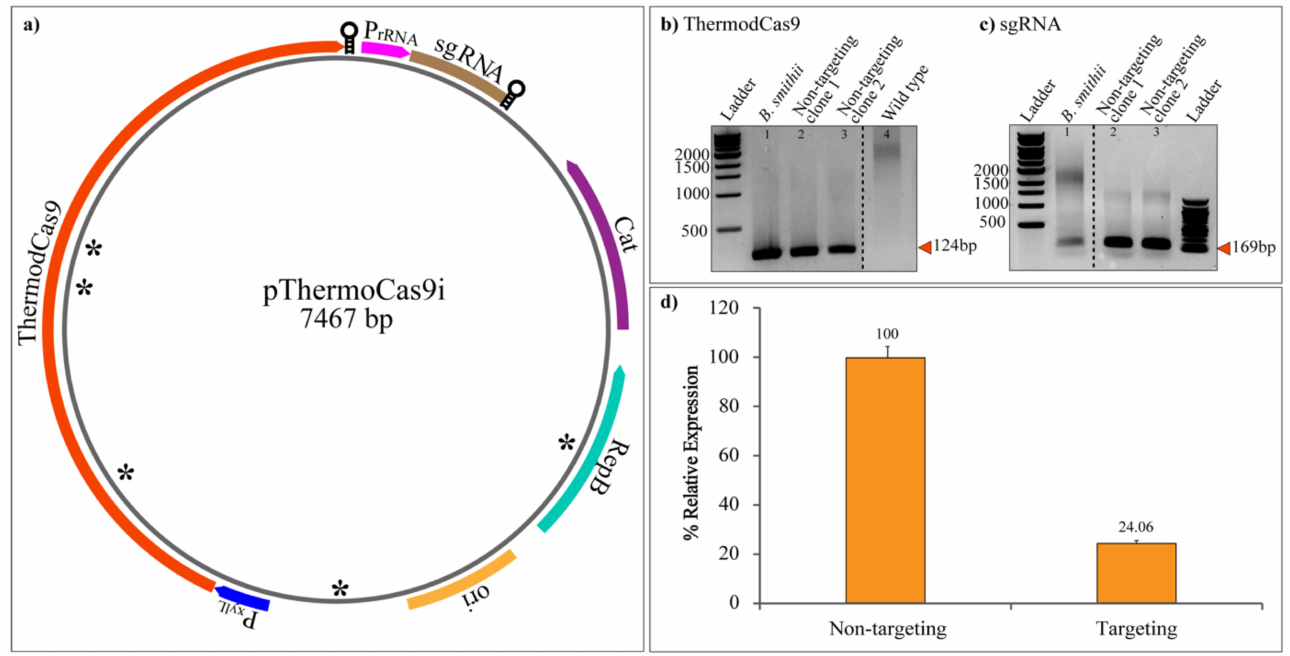
Figure 4. Transcriptional repression of malic enzyme gene by CRISPRi of P. thermosuccinogenes transformants. ( a ) Schematic representation of plasmid pThermoCas9i (Mougiakos et al. 2017b). The thermodcas9 gene under control of the B. smithii xylL promoter; sgRNA-expressing module under control of the native 16S/23S intergenic rRNA promoter from H. thermocellum ; pNW33N backbone; asterisks (*) represent the regions with mutations to eliminate RM recognition sites. ( b ) Expression of the thermodcas9 gene. Lane 1: RT-PCR with B. smithii harboring pThermoCas9i_ NT (Mougiakos et al. 2017b) cDNA (positive control); lanes 2 and 3: RT-PCR of thermodcas9 cDNA with product size 124 bp from 2 independent transformants of P. thermosuccinogenes DSM 5809 harboring pThermoCas9i_ME; lane 4RT-PCR with P. thermosuccinogenes DSM 5809 wild type cDNA (negative control). ( c ) Expression of sgRNA. Lane 1: RT-PCR with B. smithii harboring pThermoCas9i_ NT (Mougiakos et al. 2017b) cDNA (positive control); lanes 2 and 3: RT-PCR of thermodcas9 cDNA with product size 169 bp from 2 independent transformants of P. thermosuccinogenes DSM 5809 harboring pThermoCas9i_ME. ( d ) Malic enzyme gene expression in P. thermosuccinogenes DSM 5809 harboring pThermoCas9i_ME was evaluated using qRT-PCR and expressed relative to the non-targeting control strain. Data represent the mean values of three biological replicates and the standard deviation. The level of significance of the differences was estimated by means of analysis of variance (ANOVA), with the statistically significant criterion being a p -value ≤